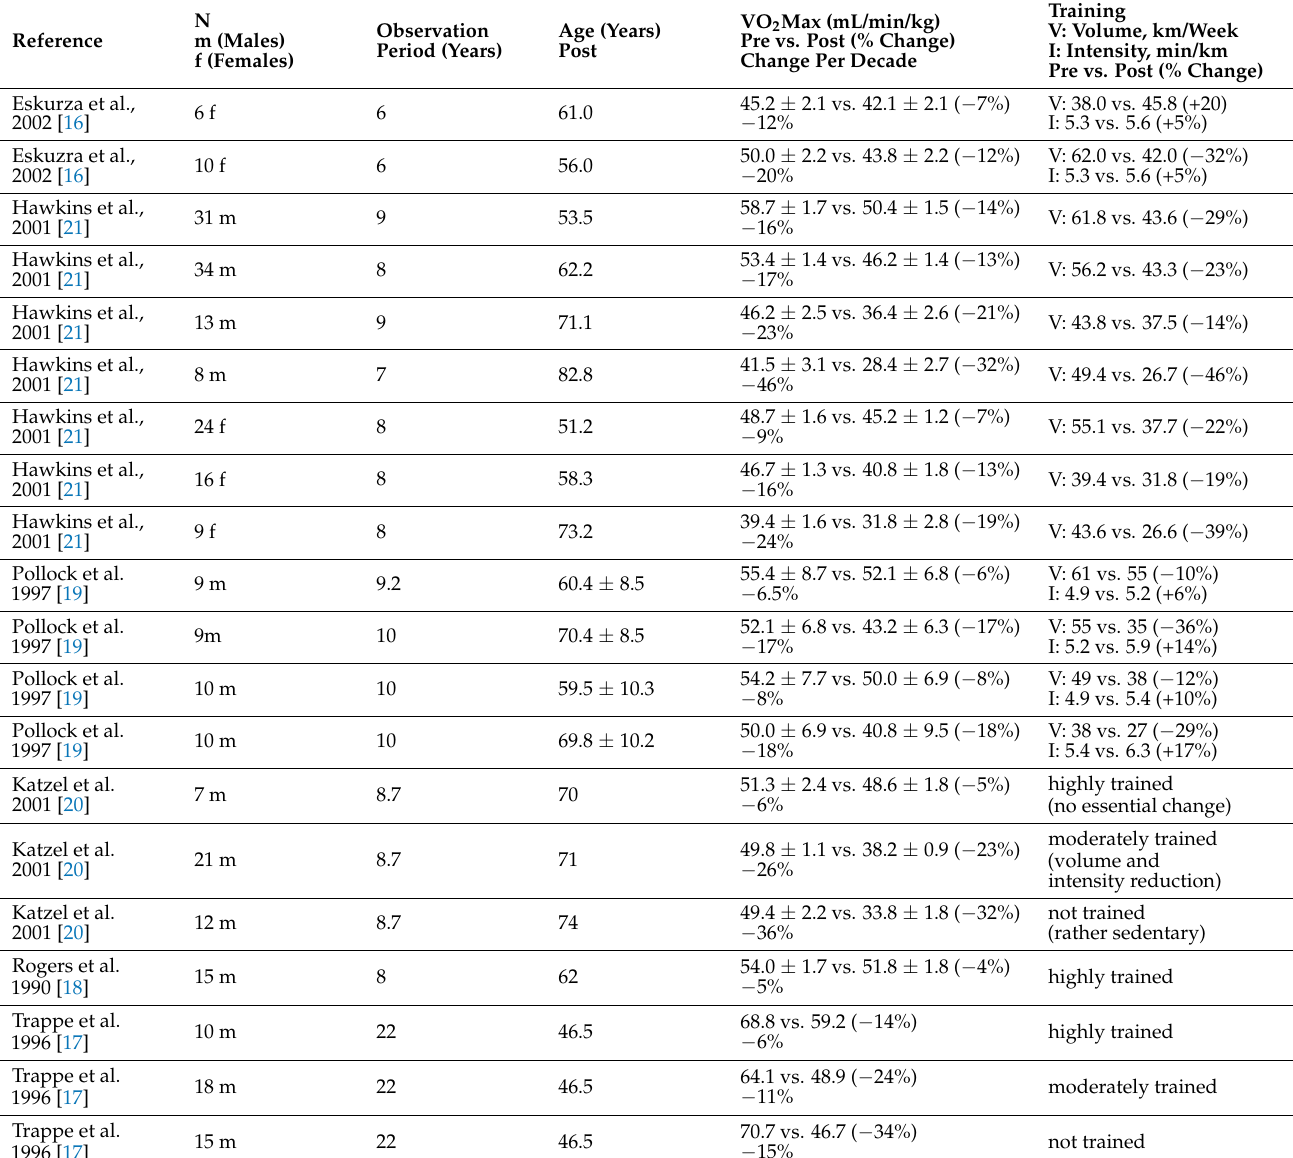
not trained Few data on training cessation or training (re)uptake responses (physiological char- acteristics) in older masters are available. Thus, results of studies on young and older endurance athletes and healthy individuals reporting short-term changes in VO 2 max and related physiological changes due to training cessation or training (re)uptake were consid- ered for this analysis (Table